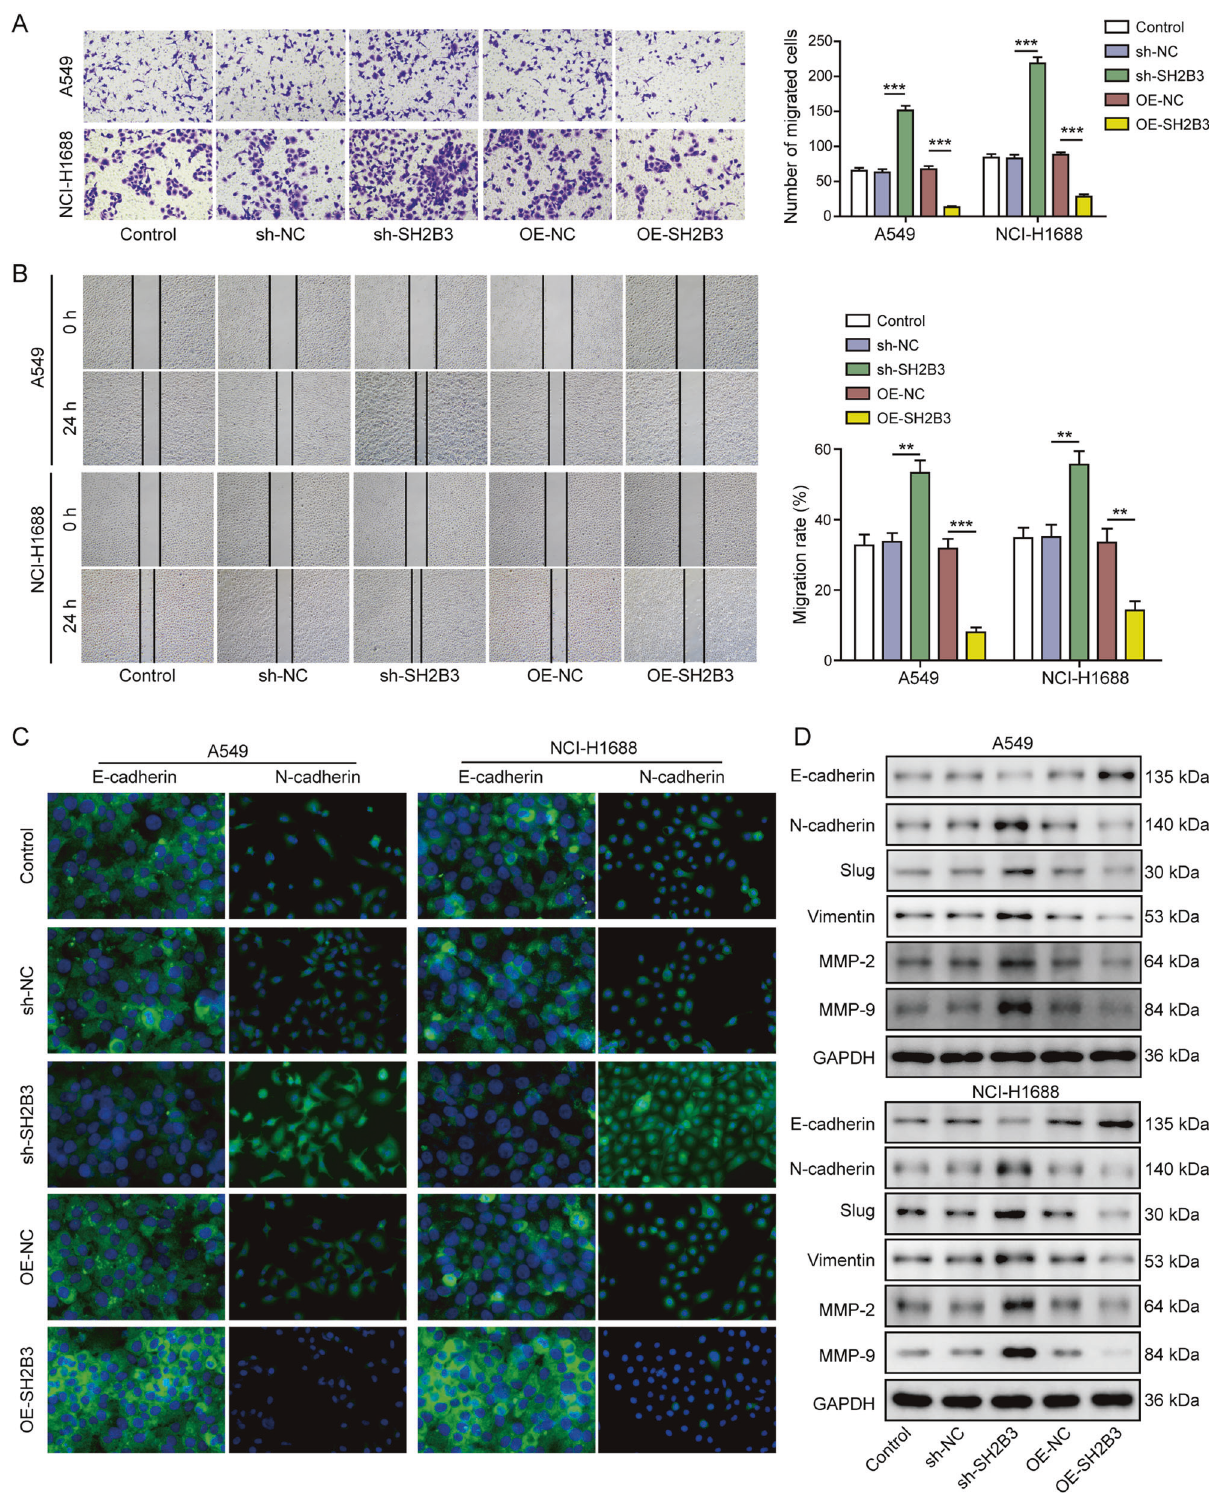
Fig. 3 SH2B3 suppressed EMT and cell migration and invasion of lung cancer. A Transwell assay to measure invasion capacity of transfected cancer cells. B Scratch wound-healing assay to determine the migration ability of transfected cancer cells. C Immunostaining to test E-cadherin and N-cadherin protein levels in transfected cancer cells. D Western blotting to measure levels of EMT-related markers including E-cadherin, N-cadherin, slug, vimentin, MMP-2, and MMP-9 in transfected cancer cells. *** P < 0.001 and ** P < 0.01.